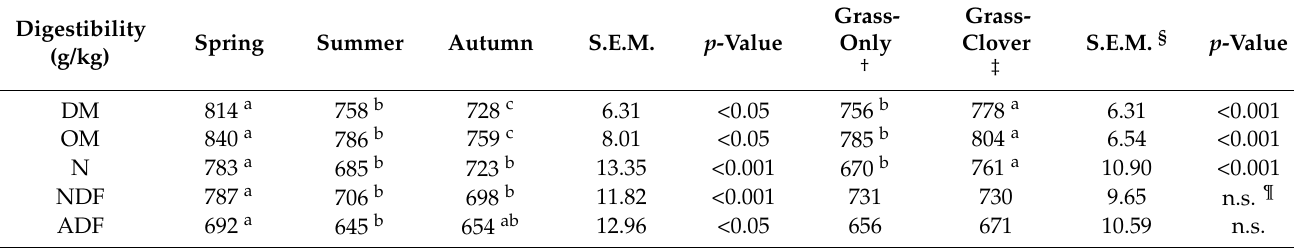
Table 4. Effect of season (spring (27 March–29 April), summer (19 June–22 July) and autumn (4–29 September)) and forage